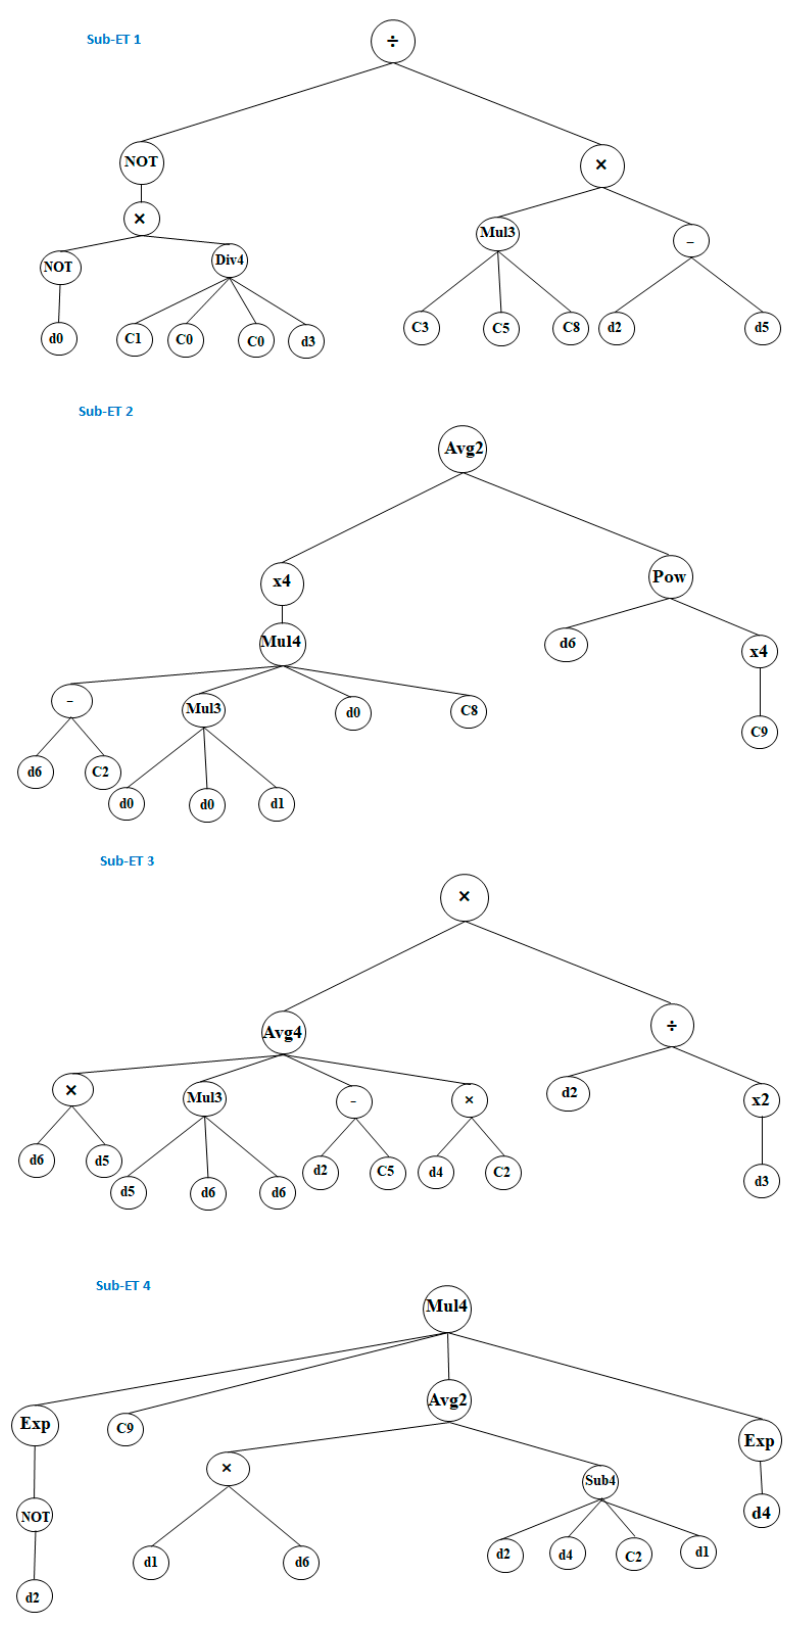
Figure 4. The correlation introduced for prediction of WAG RF in the form of an expression